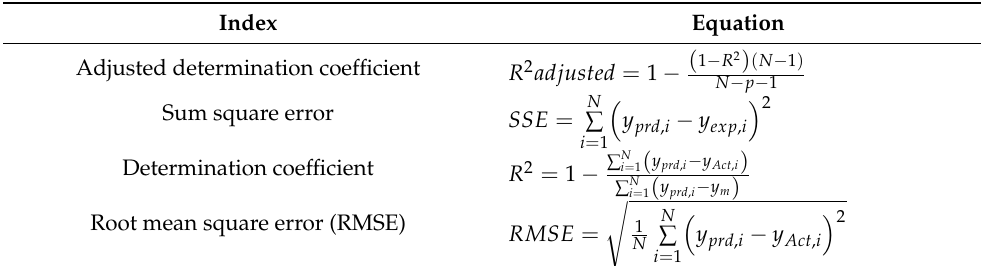
Table 2. A summary of the equations of the error